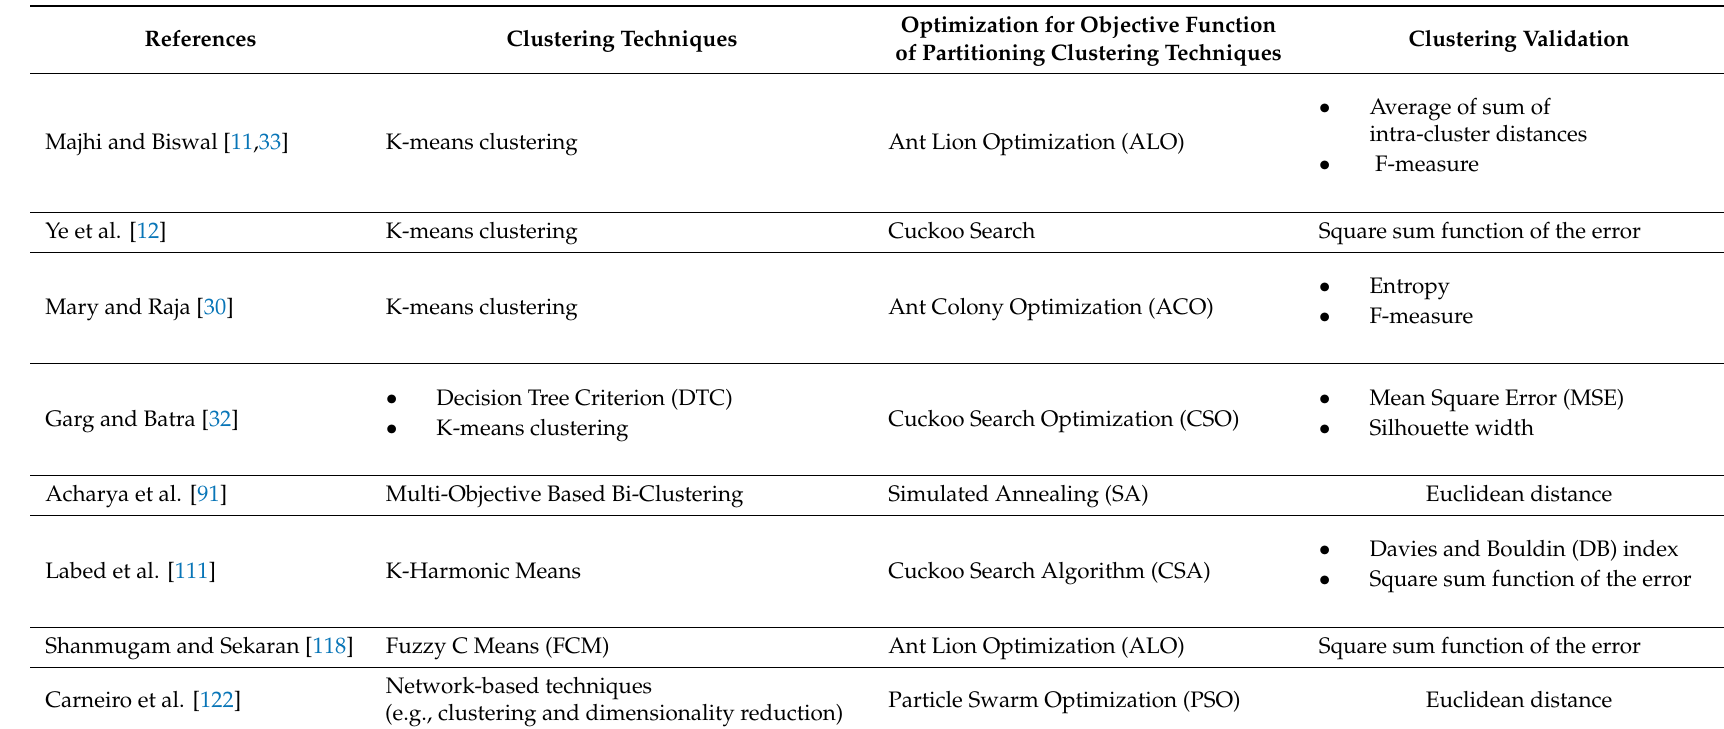
Table 9. Summary of optimal cluster